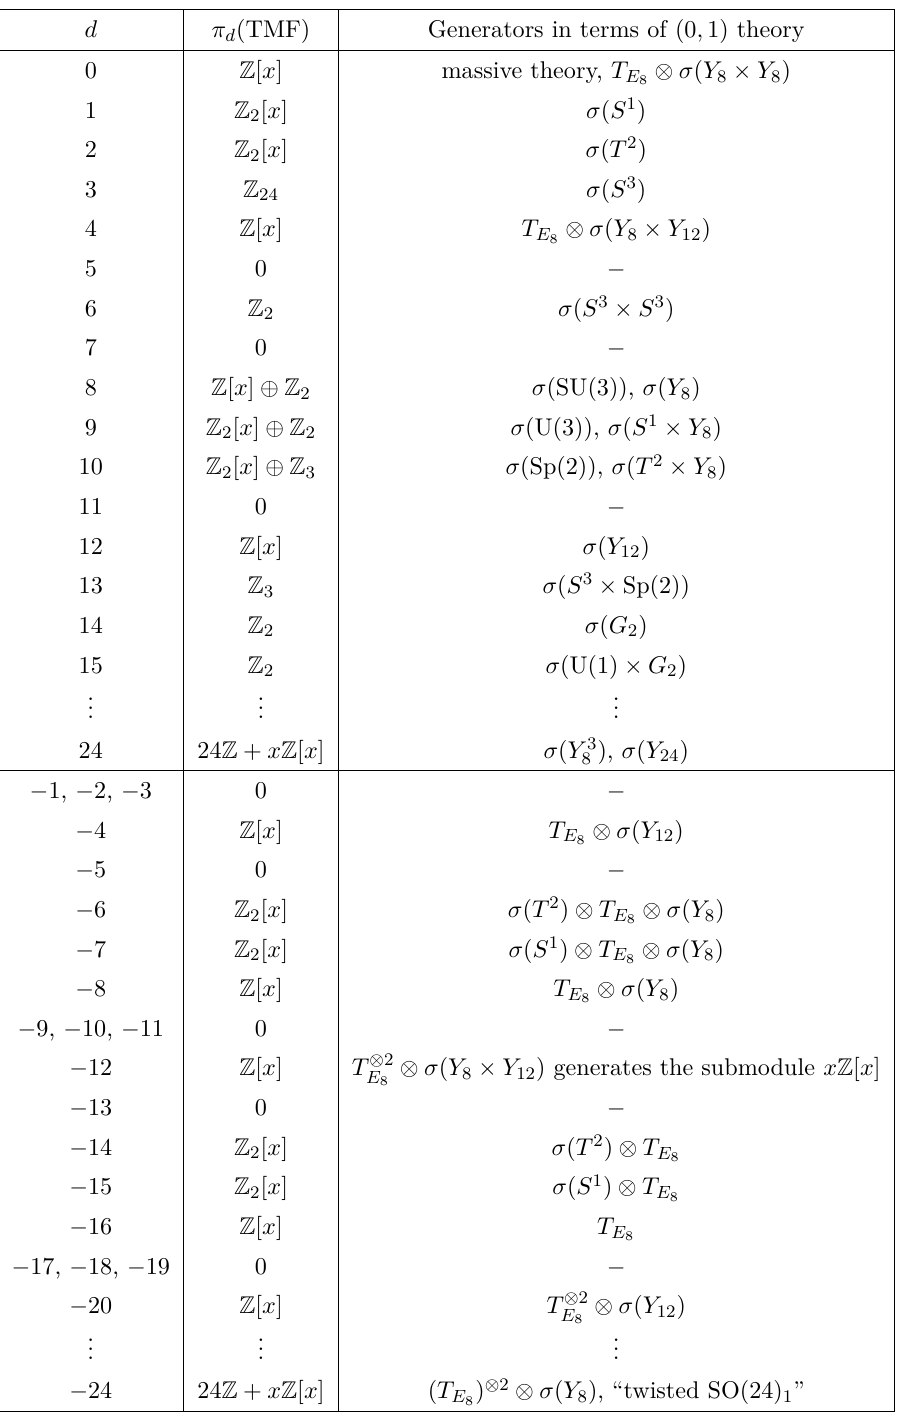
Table 2 . 2d (0 , 1) representatives for important generators of π ∗ TMF in degrees from − 24 to 24 . In degree zero, π (TMF) = Z [ x ] and we list the theories corresponding to 1 and x . In other degrees, 0 we only list the generator of π (TMF) as a Z [ x ] -module. In the table, T ∗ at level 1, σ ( M ) denotes the sigma model with target M , while Y and 24-manifolds. Details will be explained in later